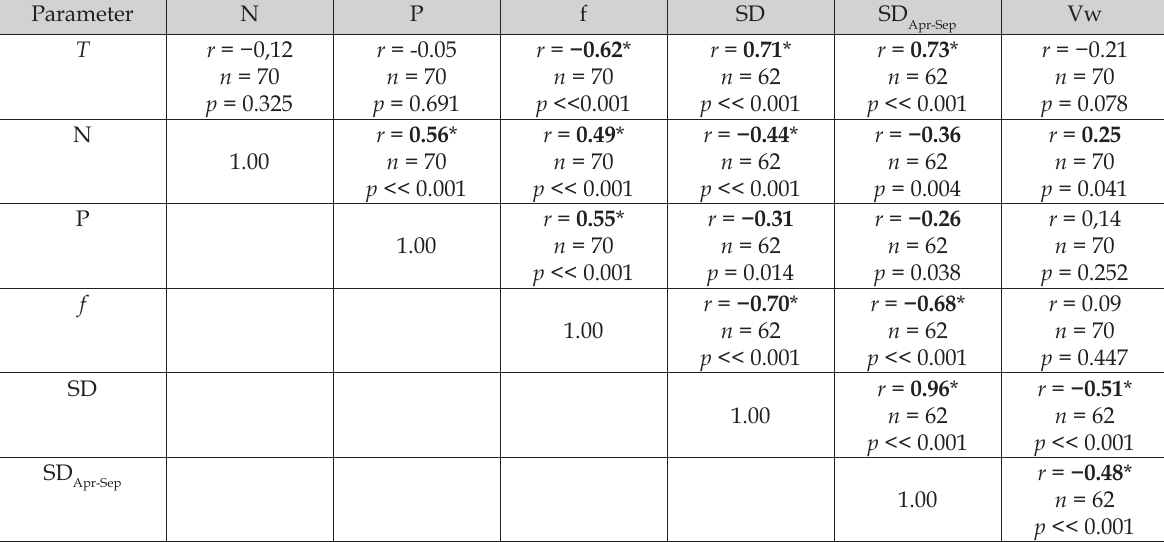
Table 2. Values of the correlation coefficients between selected climatic elements in Poznań. Parameter